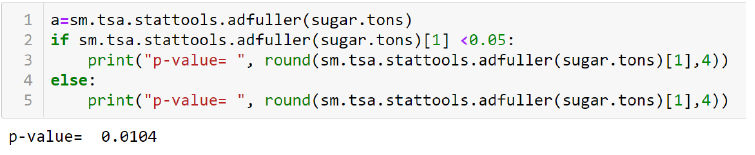
Figure 2. Implementation of the Dickey–Fuller test in